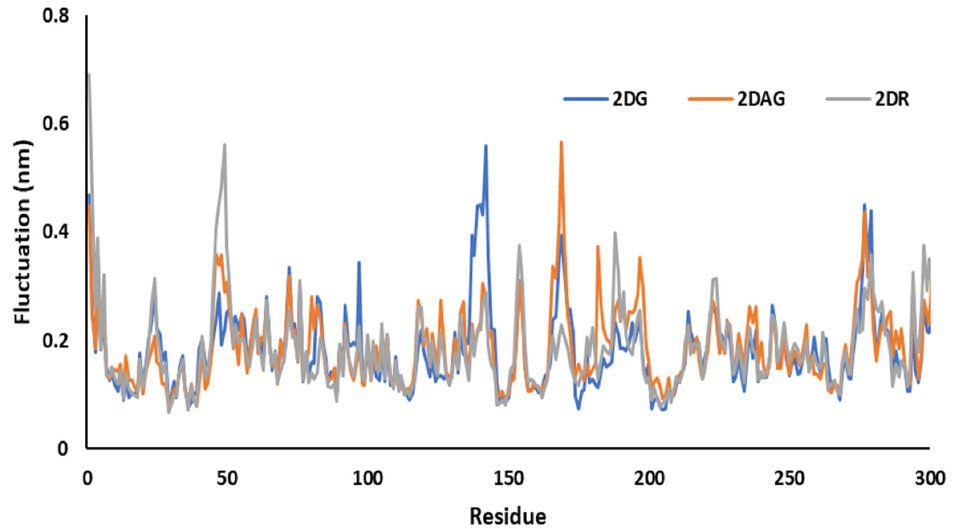
MD simulations were used to investigate the RMSF of the main protease of novel